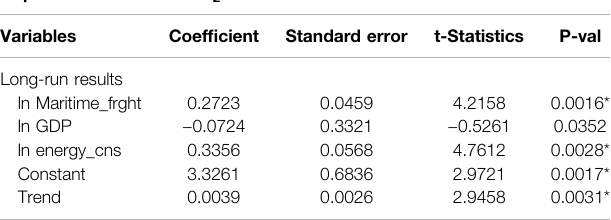
TABLE 10 | Long-term ARDL estimation results of Denmark.